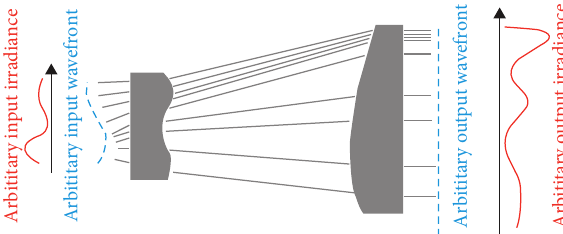
Figure 1: Beam shaper composed of two plano-freeform lenses for arbitrary input/output beams (freeform surfaces: 1 realizes irradiance transformation; 2 adjusts